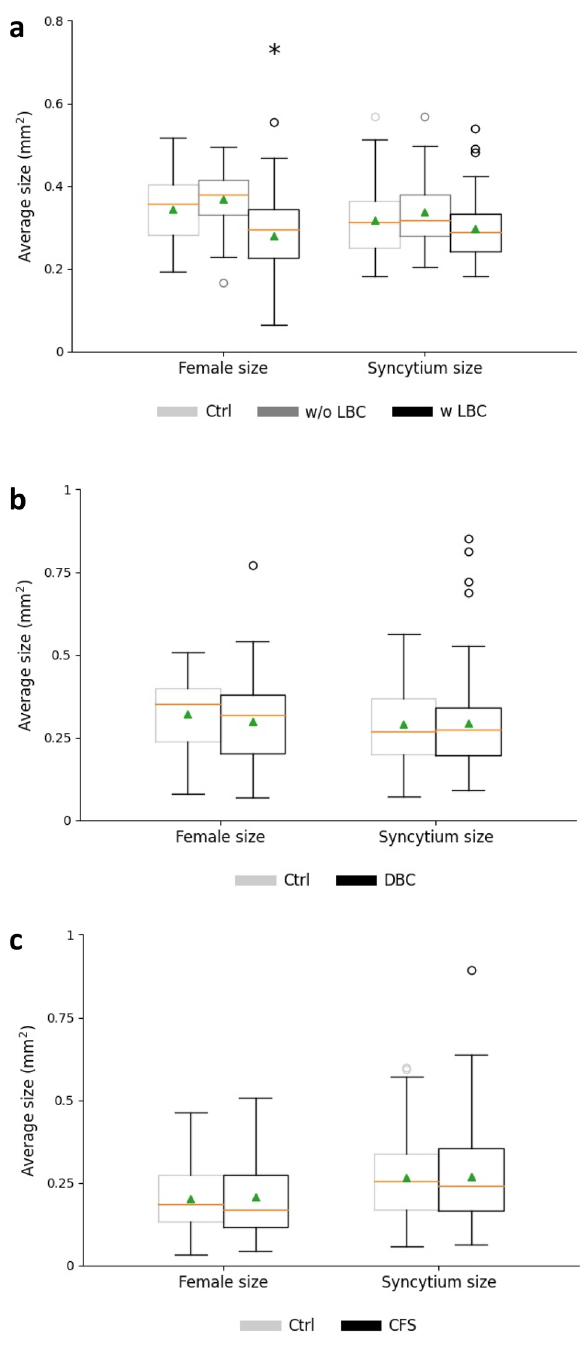
Figure 5. Development of Heterodera schachtii at Arabidopsis thaliana roots. Average size of female and syncytium at 28 dpi (days post inoculation) in the presence of LBC ( a ), DBC ( b ) or CFS ( c ). LBC living bacterial cells, DBC dead bacterial cells, CFS cell-free supernatant. Results are expressed as the mean (orange line) and median (green triangle) ± standard error of three independent biological replicates (n ≥ 53). Data are statistically analysed using Dunn’s Method. Asterisk (*) indicate statistically significant differences compared with the control ( p <